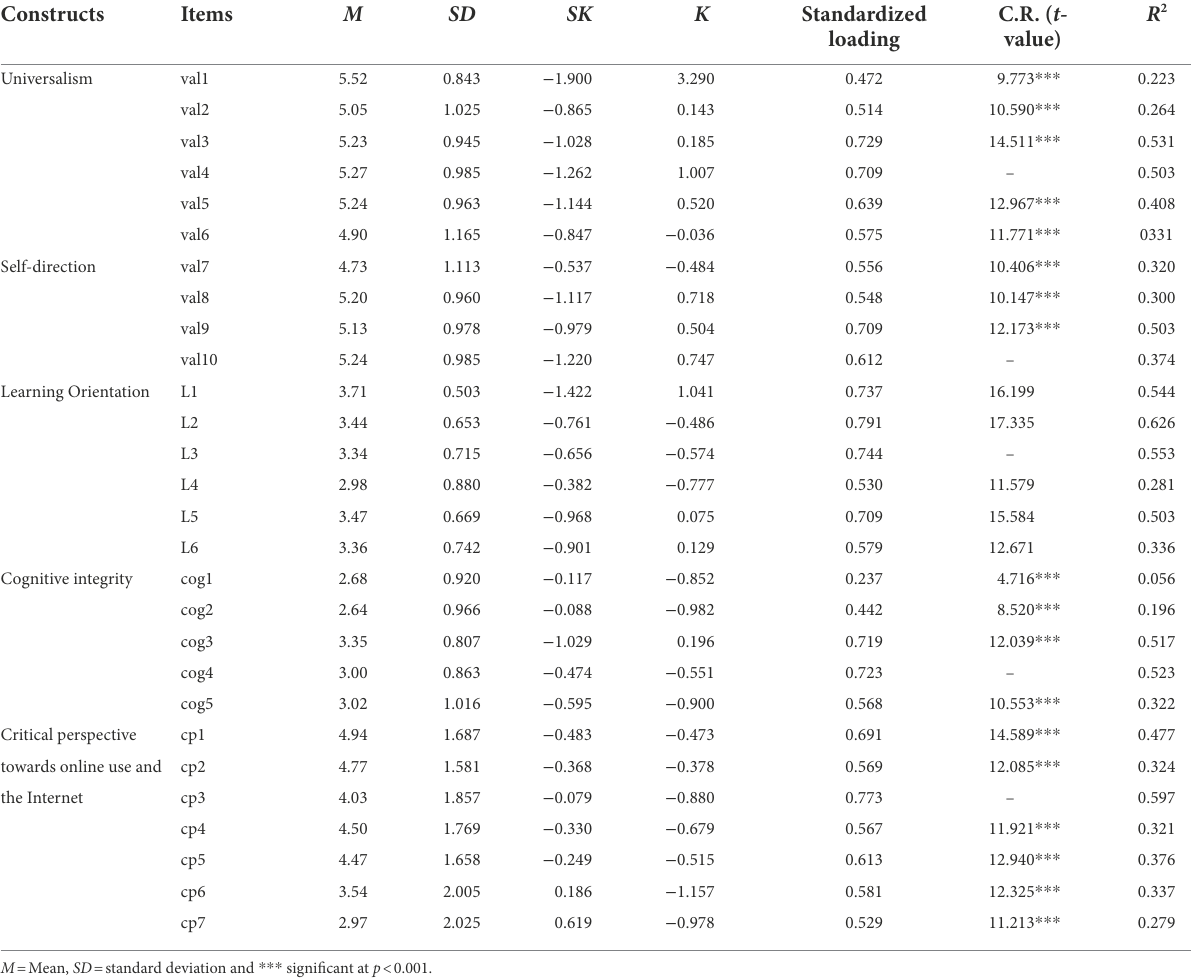
TABLE 2 Descriptive statistics and results of CFA measurement model ( N = 536).